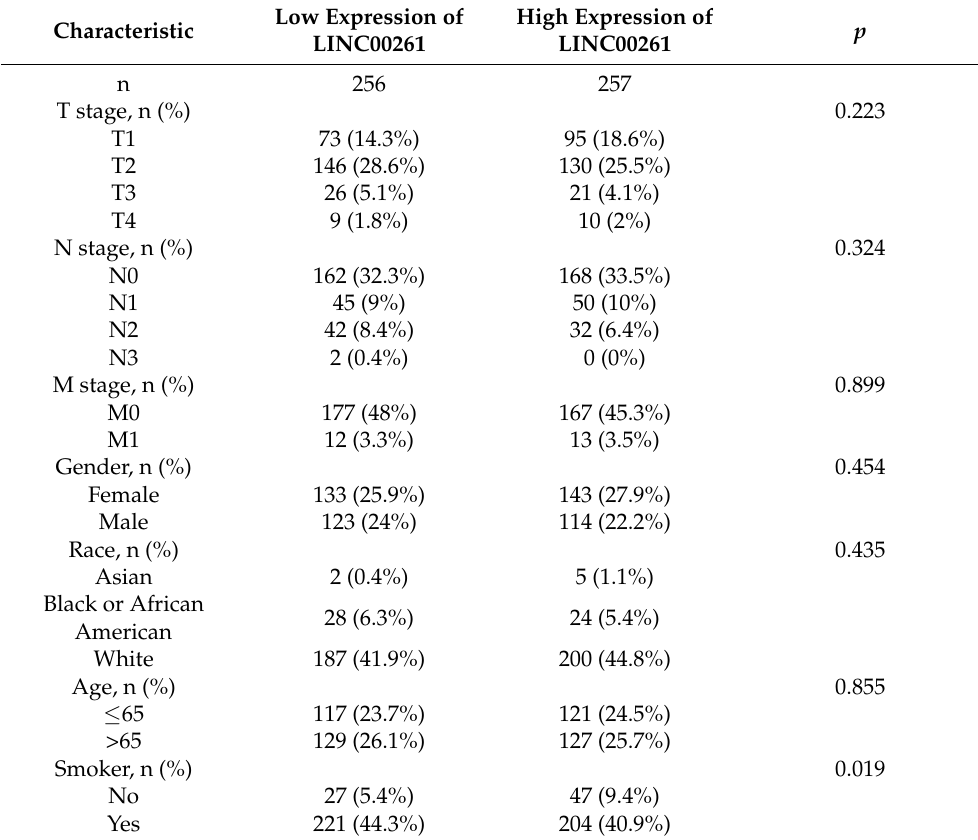
Table 2. Clinical information on LINC00261. The data for analysis were from the LUAD project in TCGA